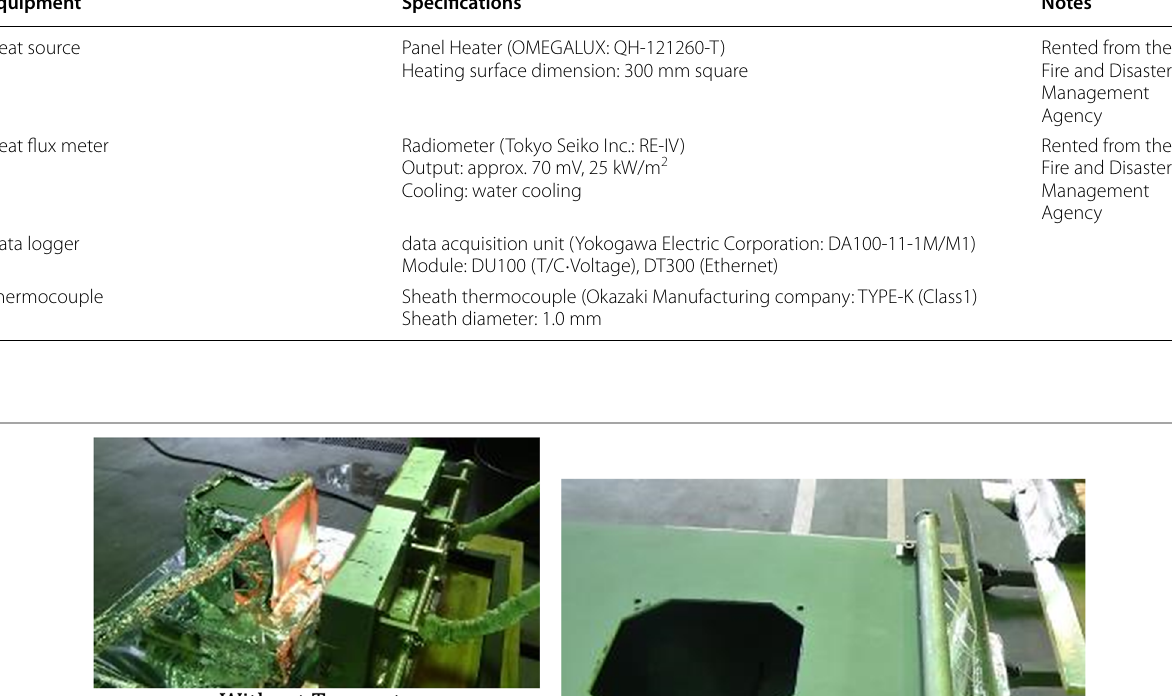
Table 3 Equipment using radiation heat-transfer experiment Equipment